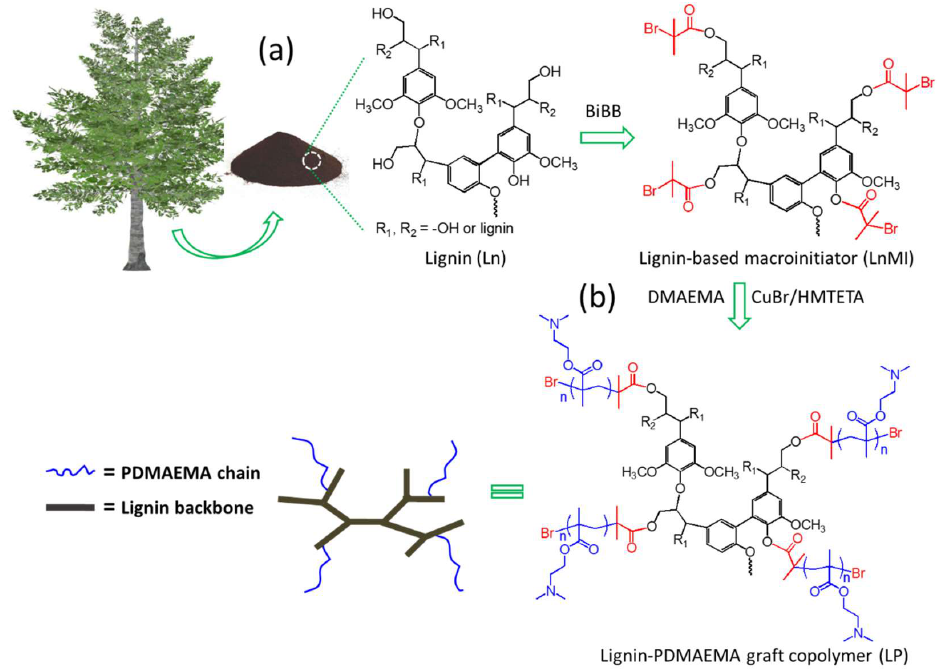
Figure 1. Synthetic procedures for ( a ) conversion of biomass lignin into lignin-based macroinitiator (LnMI) and ( b ) synthesis of lignin-based graft copolymer (LP) via Cu(I)-mediated ATRP of DMAEMA. Table 1. The selected conditions for synthesis of lignin-based macroinitiators (LnMIs) with different modification degrees. 1